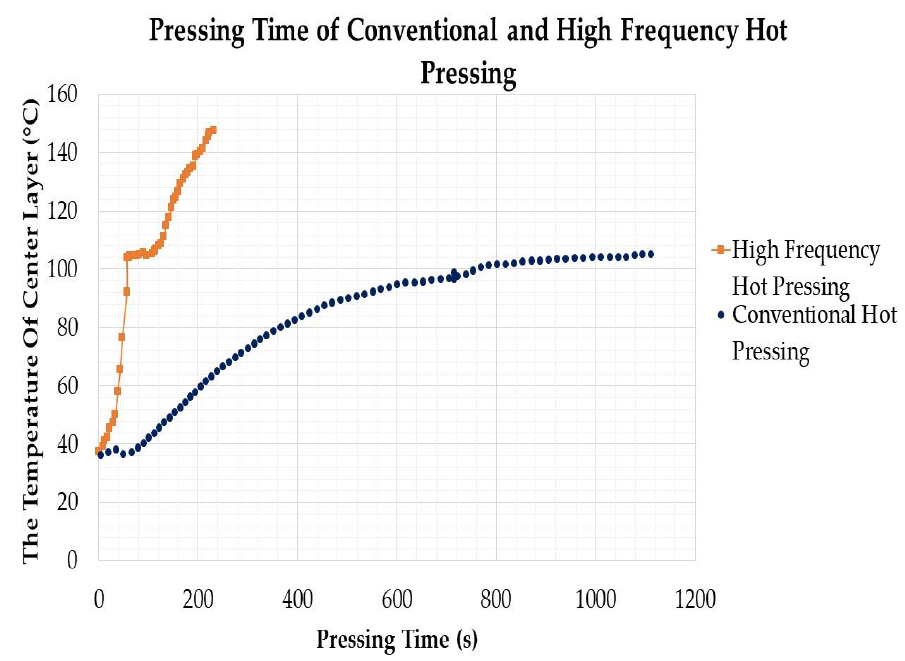
Figure 1. The graph of temperatures of center layer against pressing time [15].